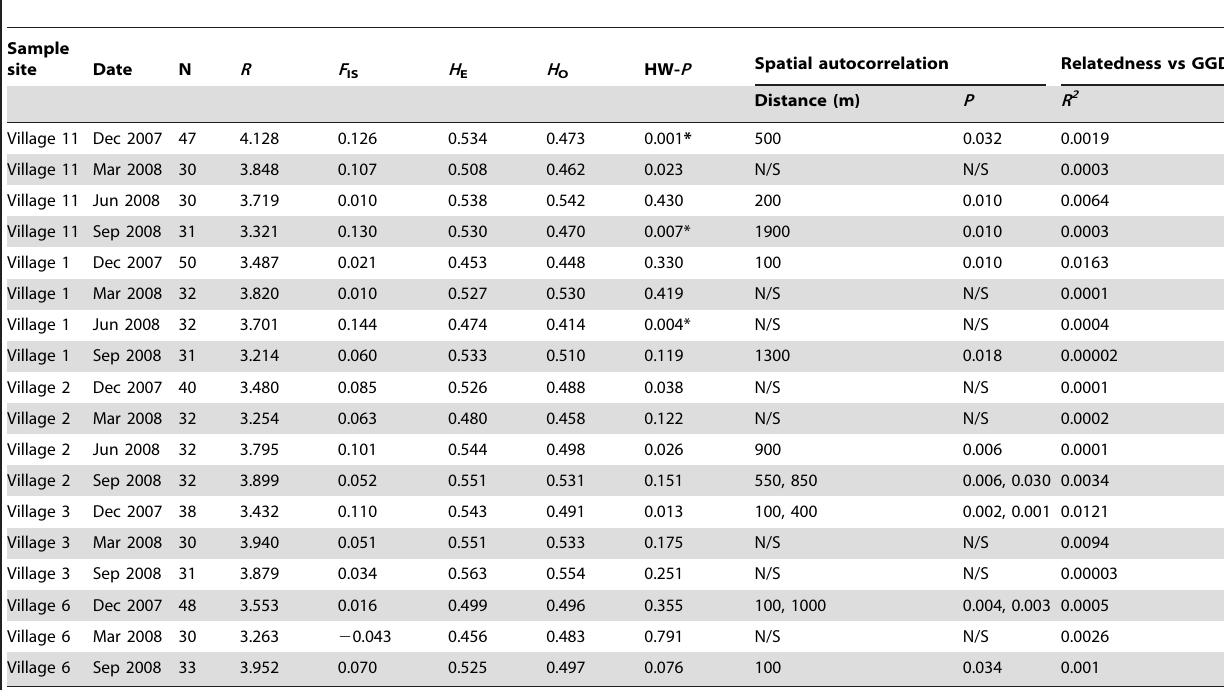
Table 1. Population characteristics of Aedes (Stegomyia) aegypti (L.) sampled from five villages in Chachoengsao Province, eastern Thailand ( r =allelic richness, F IS =inbreeding coefficient, H E =expected heterozygosity, H O = observed heterozygosity, HW- P =Hardy Weinberg P value, *significant after correction for multiple comparisons using False Discovery Rate procedures [12], N/S= no spatial autocorrelation at distances tested), Relatedness estimator [22], GGD =geographic